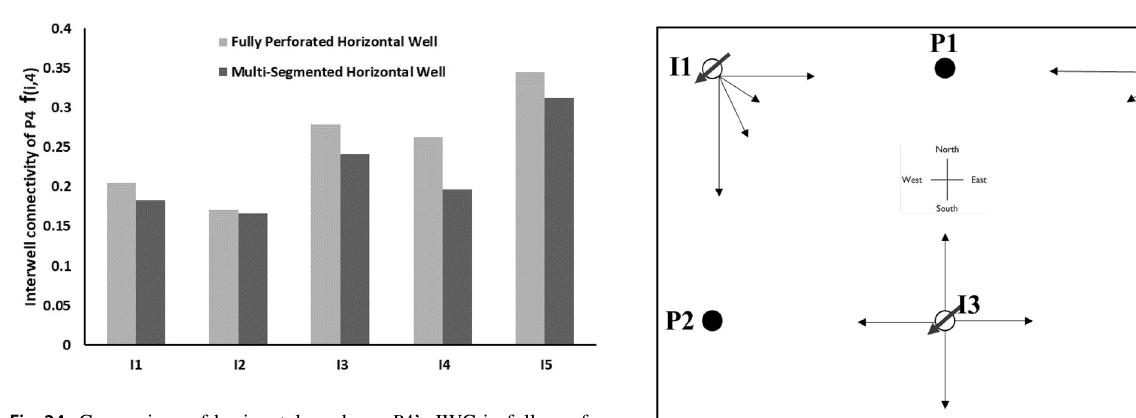
Fig. 24 Comparison of horizontal producer P 4’s IWC in fully perfo- rated (case III) and multi-segmented (case V) conditions